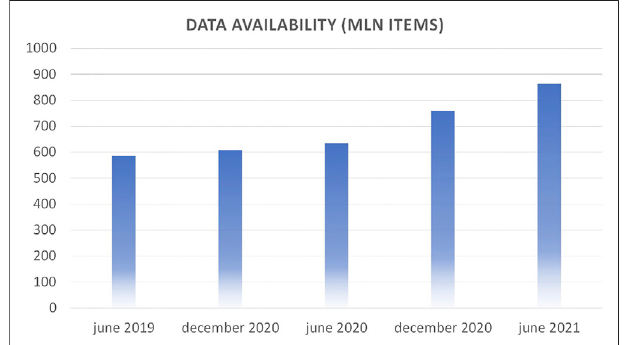
FIGURE 1 | Data availability vs time in the Gemelli Data Warehouse (millions of data